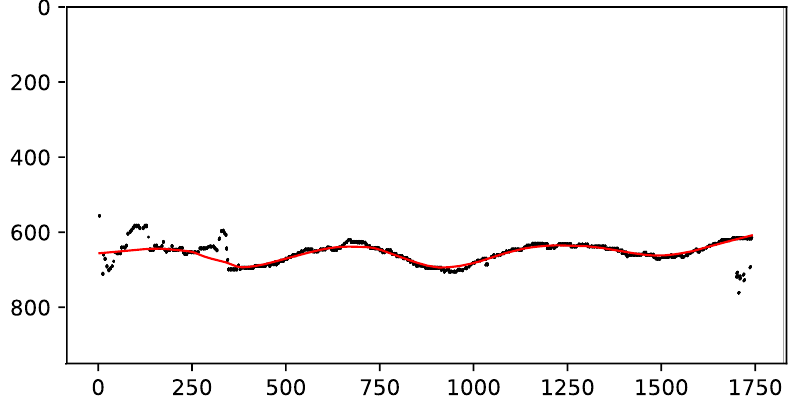
Figure 4. The black points are the curve samples and the red line is the smooth curve that was computed by the LOWESS algorithm [23]. Axes in